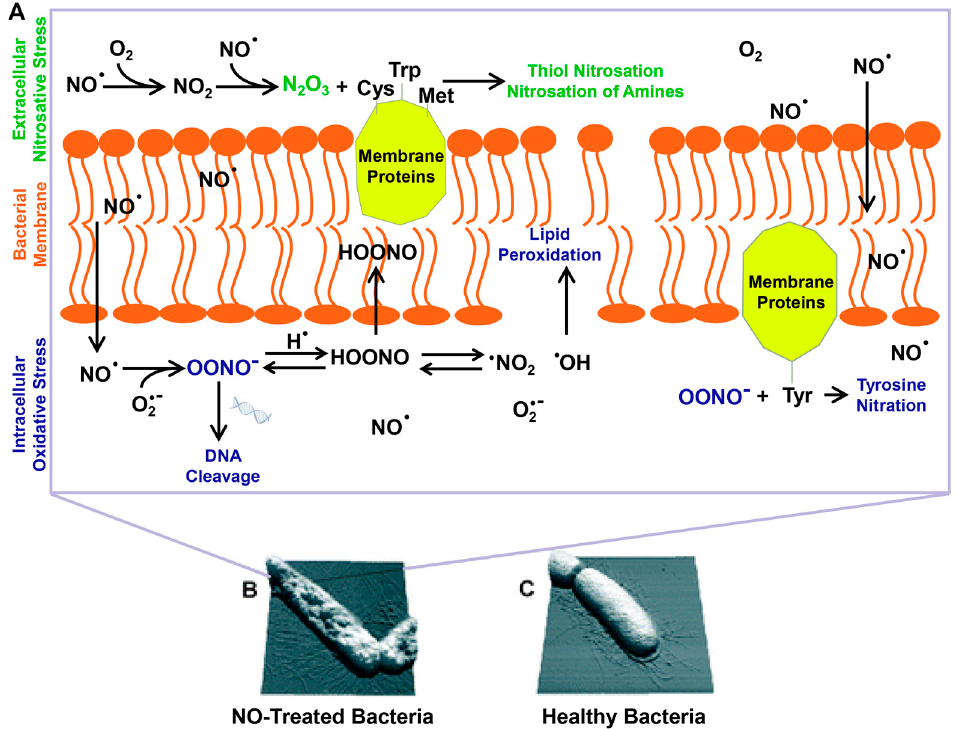
Figure 1. The multiple antimicrobial mechanisms of NO and its byproducts ( A ). Bacteria on NO releasing surfaces ( B ) and on controlled surfaces ( C ). Reproduced with permission from [47]. Copyright 2012, Royal Society of